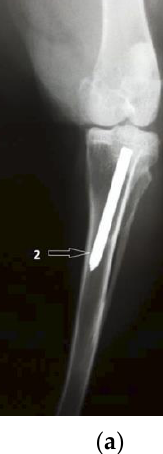
Figure 6. The radiological aspect of the austenitic steel rod implant, used as contrast: ( a ) the classic, inert aspect of bone-implant surface with no signs of degradation but without any sings of mineralization surrounding the implant either. 2-The austenitic steel rod implant; ( b ) on lateral incidence there are zones of increased transparency located both at metaphysis and diaphysis, indicating a possible osteolytic process, generated by the stress shielding effect. 2-The austenitic steel rod im- plant, 5-Zone of increased transparency, a possible osteolytic process.